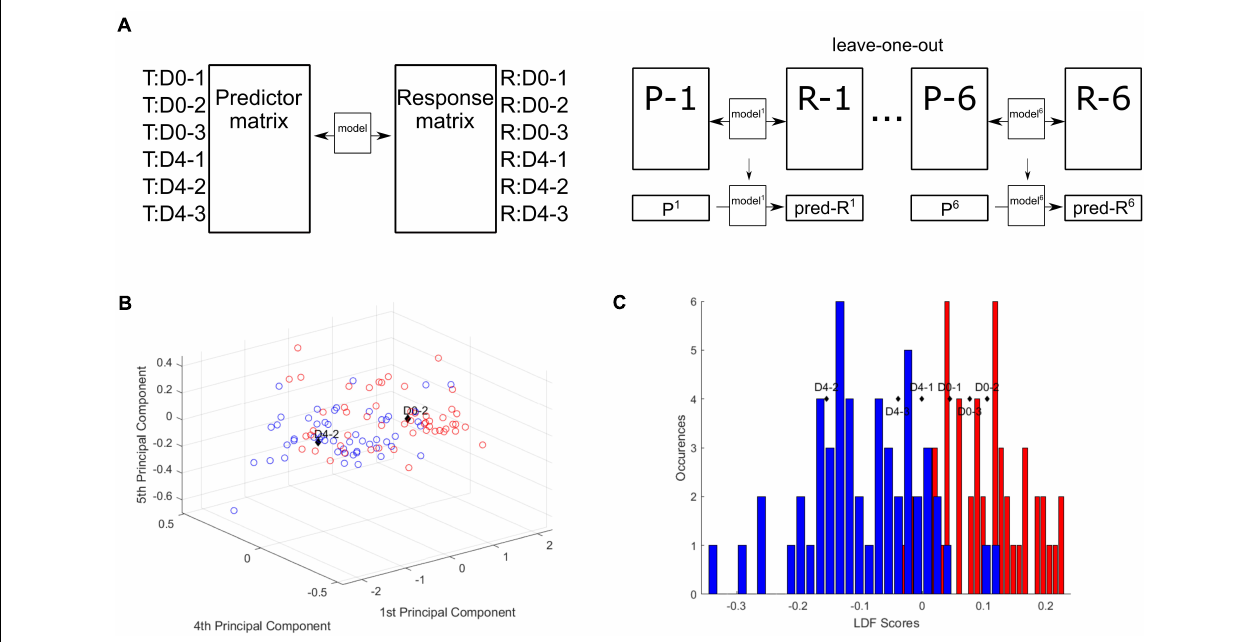
FIGURE 4 | Partial least squares regression model correlates Raman and transcriptomic data. (A) Partial least squares regression model. (B) Raman scores predicted from transcriptomic read counts. Predicted D0-2 and D4-2 plotted with the single cell scores from PC1, PC4, and PC5. (C) Predicted Raman scores converted to LDA scores and plotted against the LDA scores